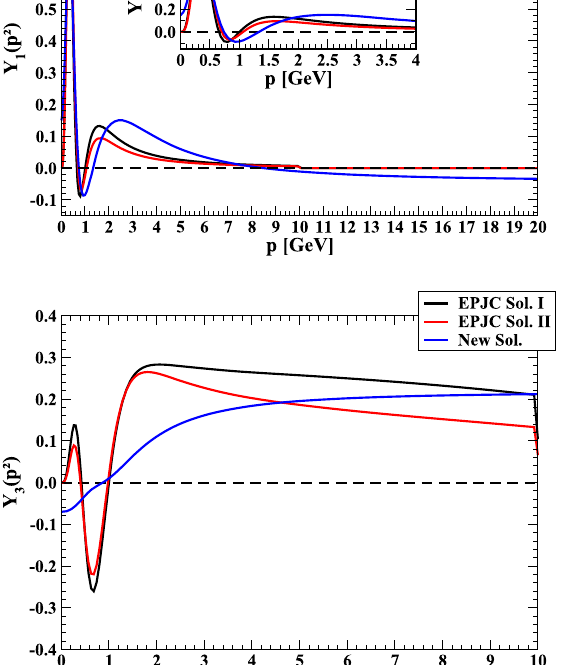
λ 2 . These situations also occurs for other values of